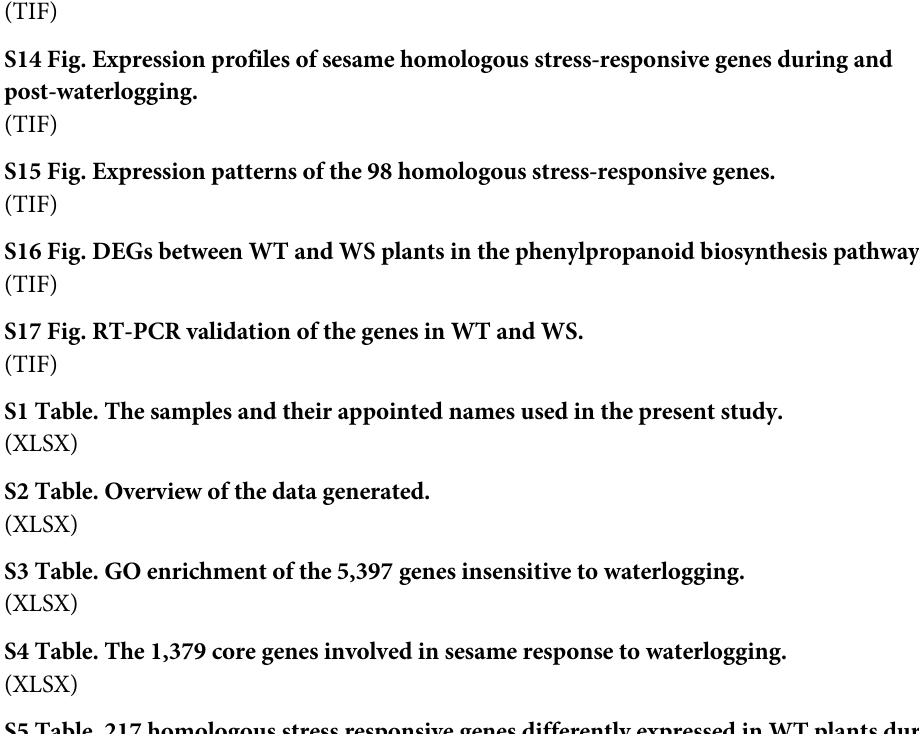
(TIF) S10 Fig. The positions of the core responsive genes in the glycolysis and gluconeogenesis pathway. (TIF) S11 Fig. Venn diagrams of the unique and common DEGs in the WT and WS genotypes at 20 h post-waterlogging. (TIF) S12 Fig. Expression patterns of the 3,016 core genes responsible for recovery from water- logging in sesame. (TIF) S13 Fig. GO categories of the enriched core gene set involved in recovery after drainage. BP: biological processes; MF: molecular function; CC: cellular component. (TIF) S14 Fig. Expression profiles of sesame homologous stress-responsive genes during and post-waterlogging. (TIF) S15 Fig. Expression patterns of the 98 homologous stress-responsive genes. (TIF) S16 Fig. DEGs between WT and WS plants in the phenylpropanoid biosynthesis pathway. (TIF) S17 Fig. RT-PCR validation of the genes in WT and WS. (TIF) S1 Table. The samples and their appointed names used in the present study. (XLSX) S2 Table. Overview of the data generated. (XLSX) S3 Table. GO enrichment of the 5,397 genes insensitive to waterlogging. (XLSX) S4 Table. The 1,379 core genes involved in sesame response to waterlogging. (XLSX) S5 Table. 217 homologous stress responsive genes differently expressed in WT plants dur- ing waterlogging from 3 to 15 h. (XLSX) S6 Table. 187 homologous stress-responsive genes differentially expressed in WS during waterlogging between 3 and 15 h. (XLSX) S7 Table. 98 shared homologous stress-responsive DEGs in both WT and WS plants during waterlogging between 3 and 15